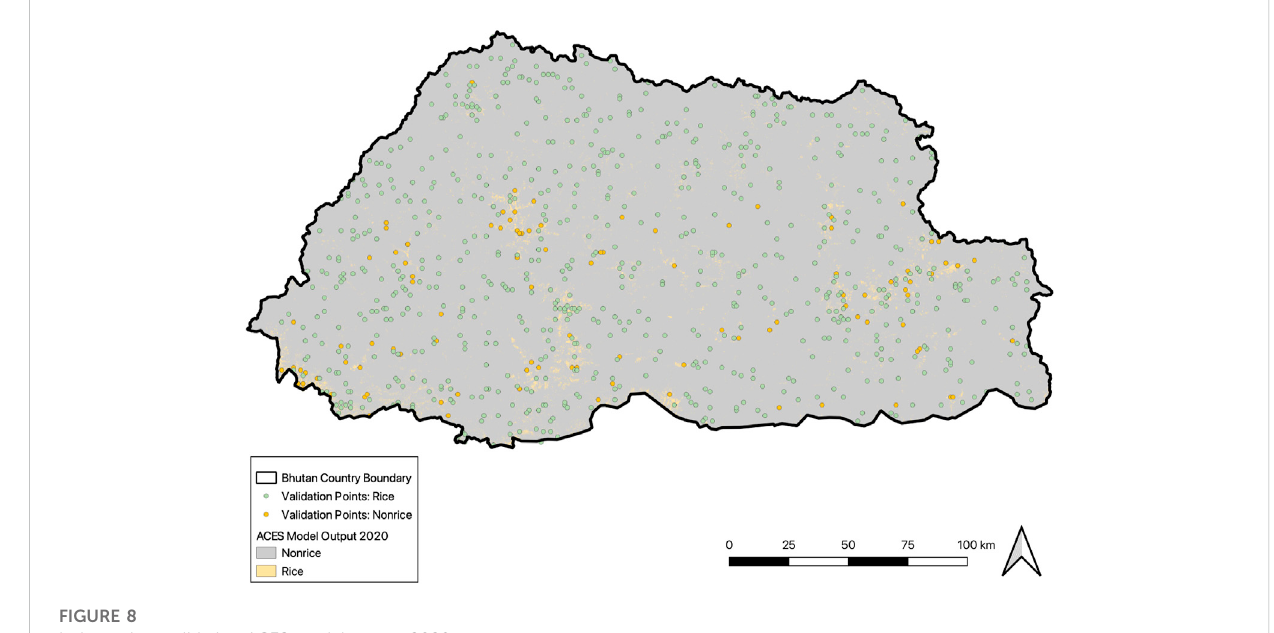
FIGURE 8 Independent validation ACES model output